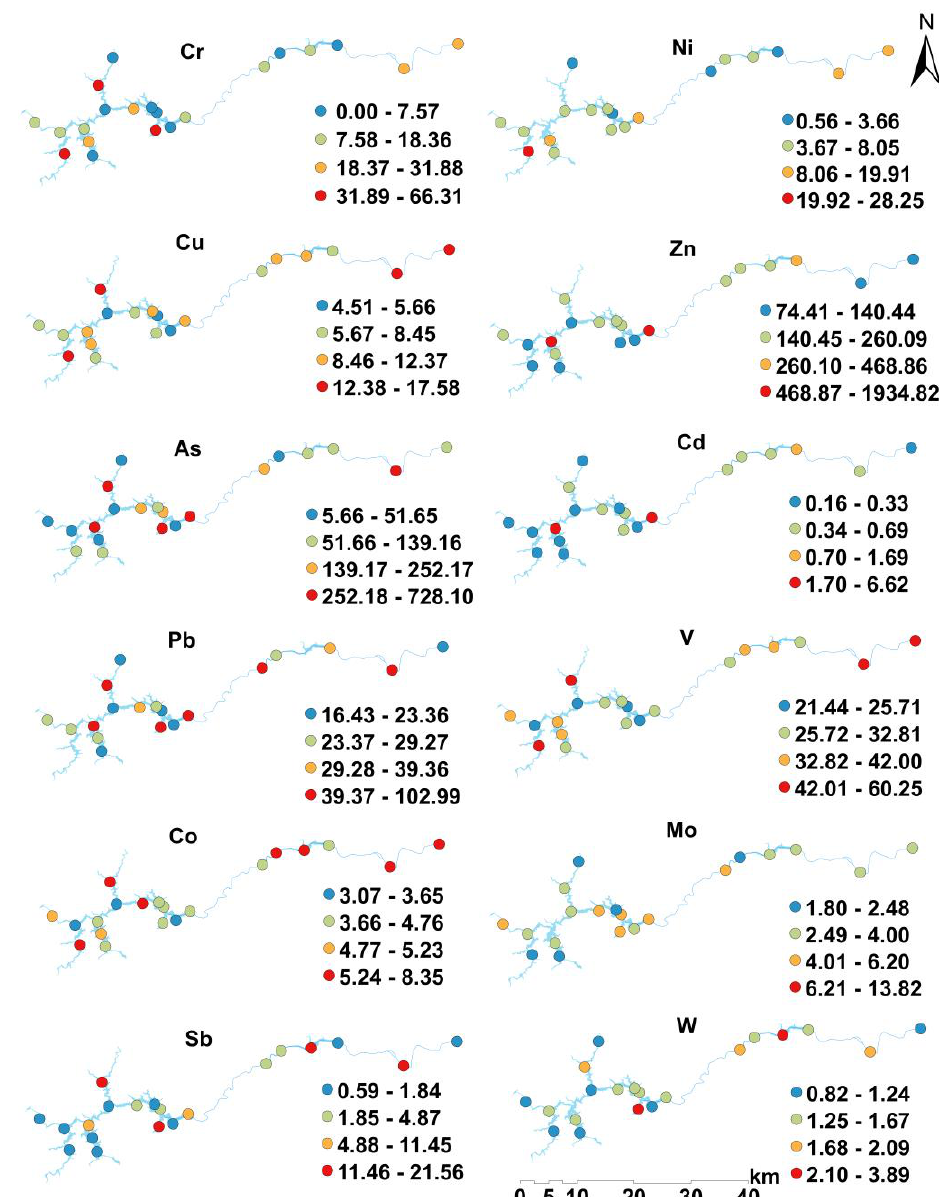
Figure 2. Spatial distribution characteristics of heavy metal concentrations in sediments of Feiyun River Basin.